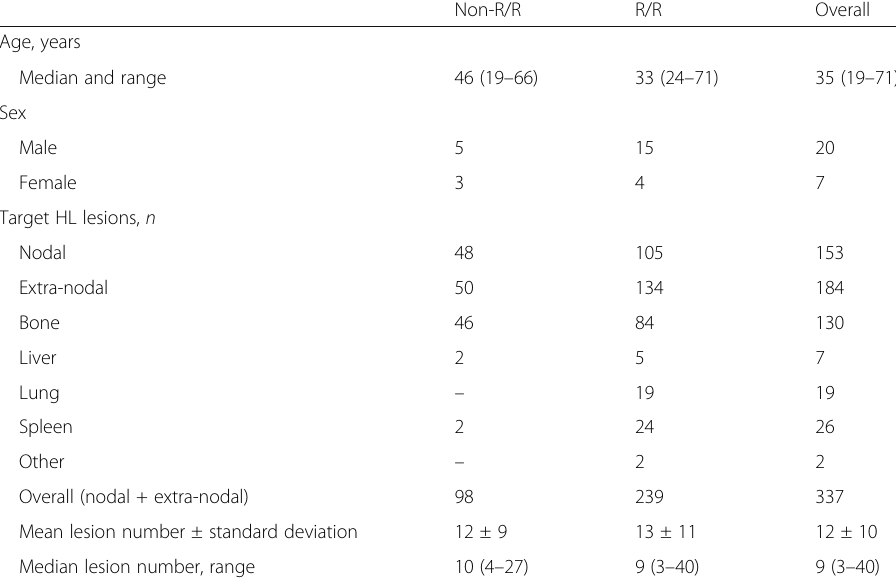
Table 1 Baseline characteristics of HL patients with both nodal and extra-nodal multiple